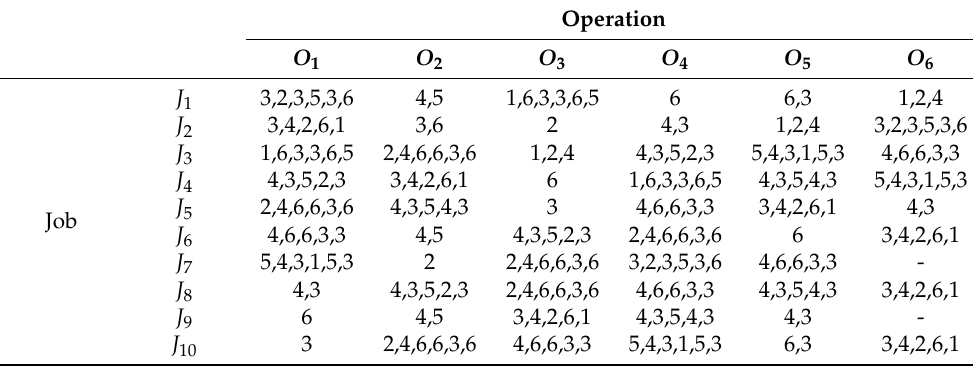
Table 11. The corresponding time of the machine in Table 10.